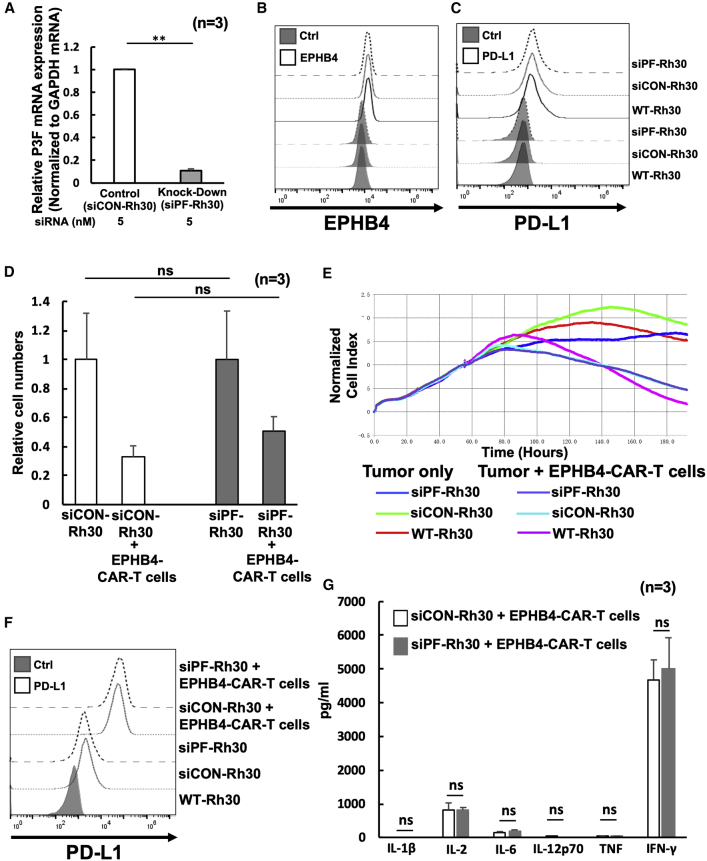
PAX3-FOXO1 (P3F) fusion gene did not affect the antitumor efficacy of EPHB4-CAR-T cells(A) After transfection with siRNAs against P3F (siPF) into Rh30 cells for 24 h, the knocked-down efficacy of siPF against P3F was assessed by quantitative reverse-transcription polymerase chain reaction (qRT-PCR). ∗∗p < 0.01. (B and C) P3F did not affect EPHB4 (B), and PD-L1 was assessed by flow cytometry (C). (D) Comparison of the antitumor effect in siCON-Rh30 and siPF-Rh30 assessed by flow cytometry. The antitumor effect of the EPHB4-CAR-T cells on the Rh30 cells was evaluated according to the ratio of survival of the Rh30 cells alone to the survival of the Rh30 cells co-cultured with EPHB4-CAR-T cells. Mean ± SD from 3 different experiments are shown. N = not significant. (E) Cell growth of siCON- and siPF-Rh30 co-cultured with EPHB4-CAR-T cells was acquired by a xCELLigence real-time cell analysis. (F) PD-L1 expression between siCON-Rh30 and siPF-Rh30 treated with EPHB4-CAR-T cells was evaluated via flow cytometry. (G) The level of cytokines in the co-culture supernatant siCON-Rh30 or siPF-Rh30 with EPHB4-CAR-T cells for 24 h.